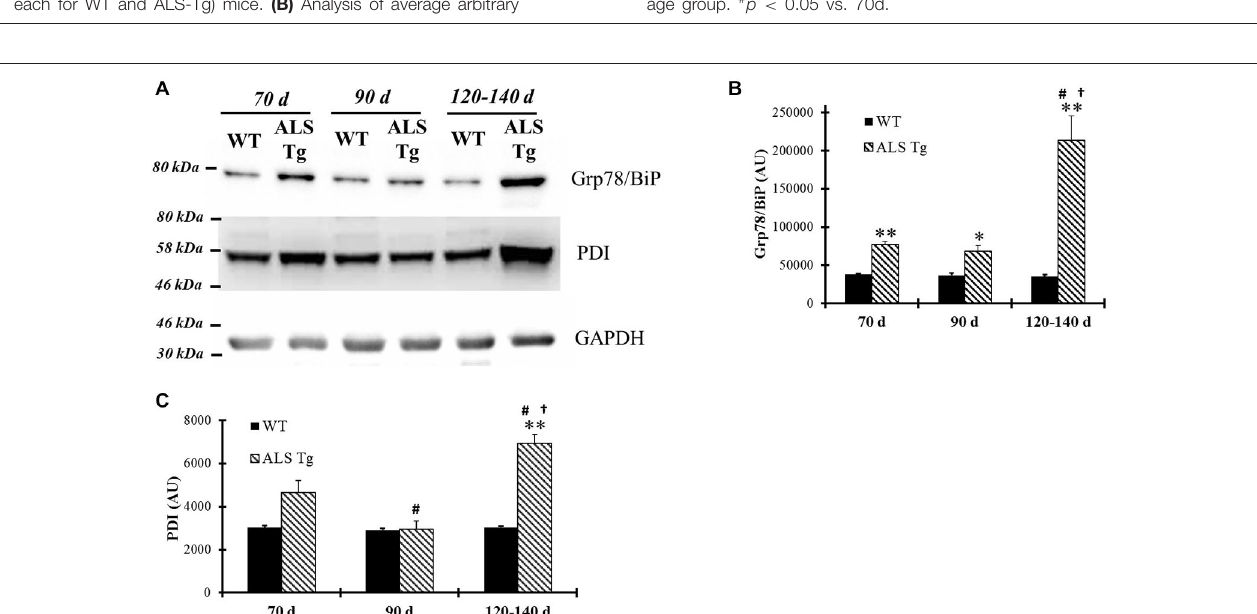
FIGURE 3 | IRE1 α protein level and spliced Xbp-1 transcriptional level are up-regulated in skeletal muscle of G93A*SOD1 ALS-Tg mice . (A) Protein was isolated from WG muscle of different ages of wild-type (WT) and transgenic G93A*SOD1 (ALS-Tg) mice and western blot was performed by using antibody specific for IRE1 α . GAPDH was used as the total protein loading control. Three postnatal ages were examined as follows: early pre-symptomatic (70d; n = 3 each for WT and ALS-Tg), late pre-symptomatic (90d; n = 5 each for WT and ALS-Tg), and symptomatic (120–140d; n = 3 each for WT and ALS-Tg) mice. (B) Analysis of average arbitrary